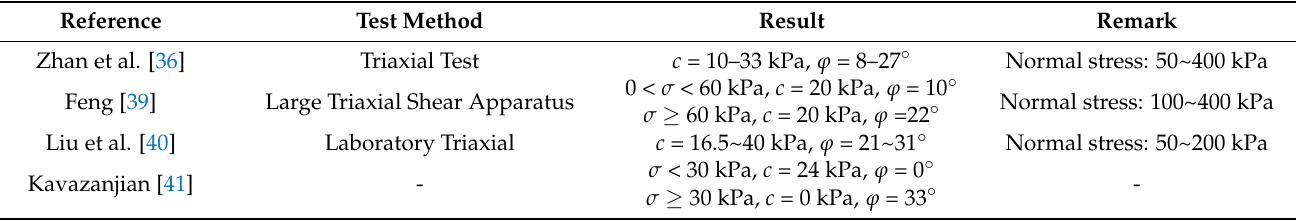
Table 1. Strength parameters of MSW.